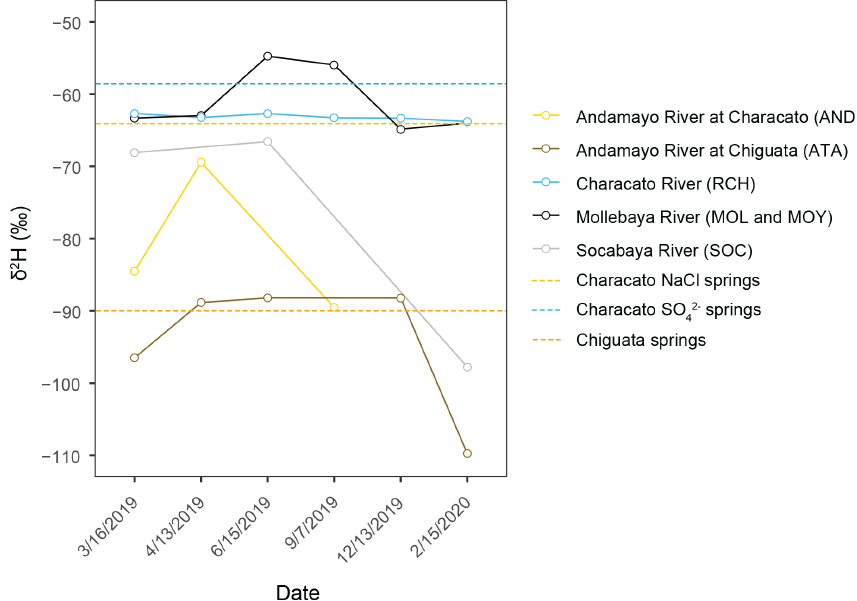
Figure 4. Deuterium composition time series of rivers in the Characato and Chiguata districts show isotopic compositions similar to nearby springs, indicating strong groundwater influence on surface waters. MOL and MOY refer to the Río Mollebaya during the wet and dry seasons, respectively. Dashed lines indicate average deuterium compositions of low-elevation springs during the same sampling period. Characato NaCl springs’ minimum and maximum are − 67 . 8‰ and − 65 . 6‰; Characato sulfate springs’ minimum and maximum are − 66 . 4‰ and − 58 . 2‰; and Chiguata springs’ minimum and maximum are − 97 . 2‰ and − 85‰.